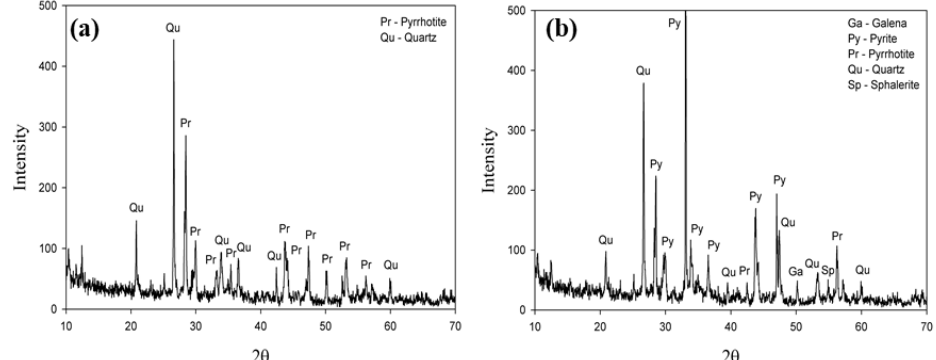
Figure 1. XRD results of the mine waste after magnetic separation: ( a ) magnetic fraction; ( b ) non-magnetic fraction.